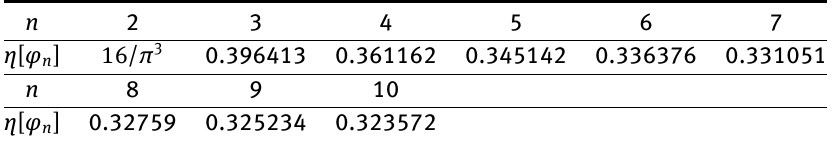
Table 3: The values of η [ φ n ] for n = 2, 3 . . . , 10 .